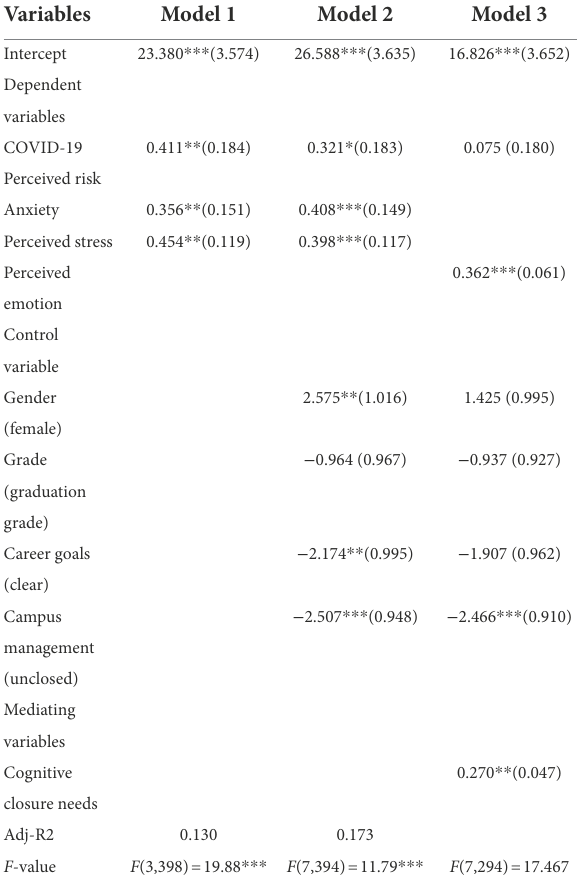
TABLE 2 Regression results of factors influencing academic involution behavior.